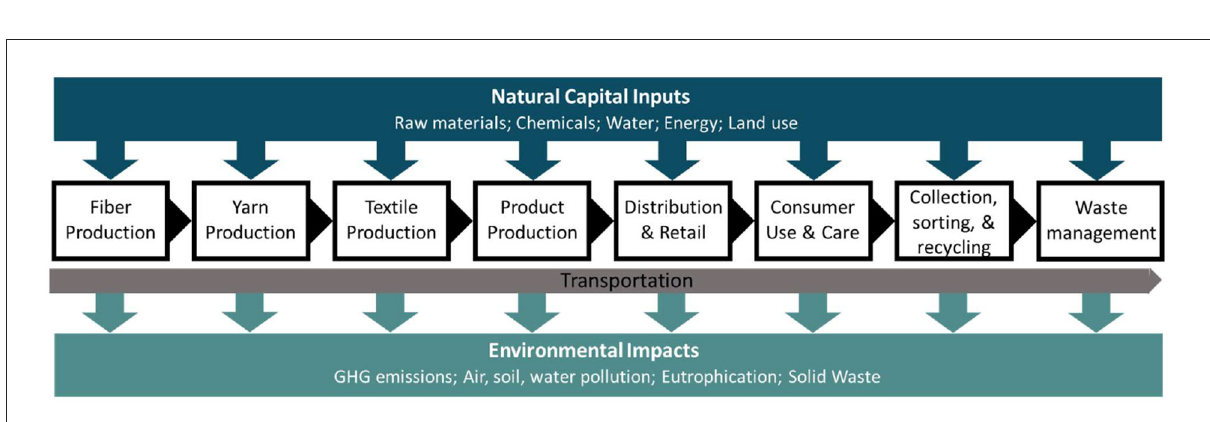
FIGURE2 Current linear supply chain of textile products with associated natural capital inputs and environmental impacts [adapted from Niinimäki et al. (2020); European Environment Agency (2021)].